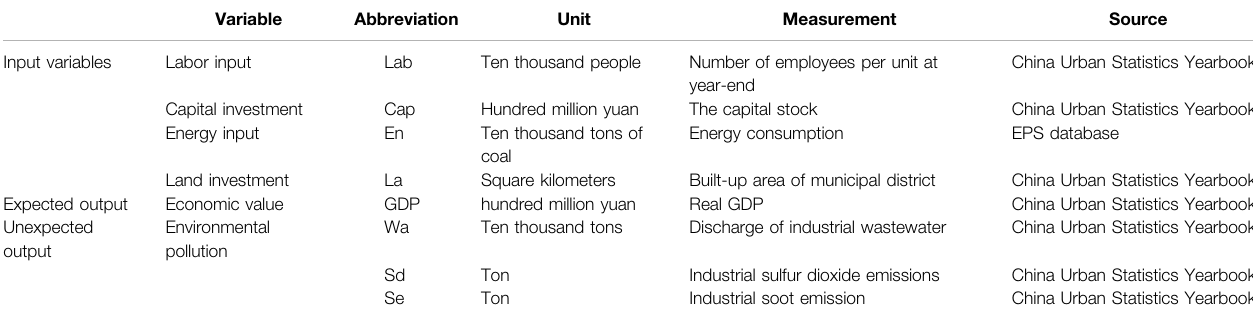
TABLE 1 | Input-output variables used to measure urban ecological ef fi ciency.